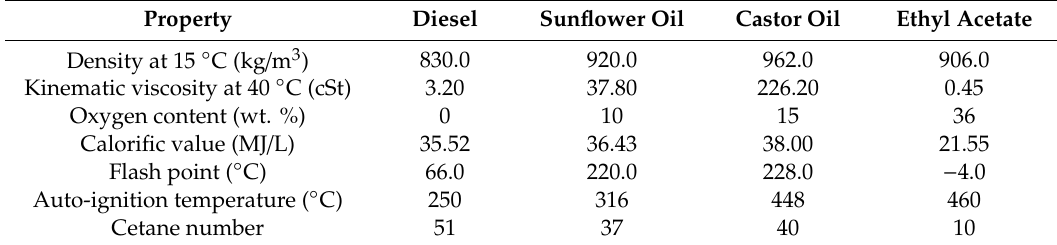
Physicochemical properties of fossil diesel, sunflower oil, castor oil, and ethyl acetate [22,23,27,29,30]. Kinematic viscosity values have been experimentally measured in the present